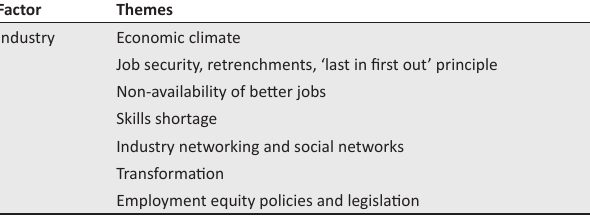
TABLE 3: Themes emerging from industry factors.